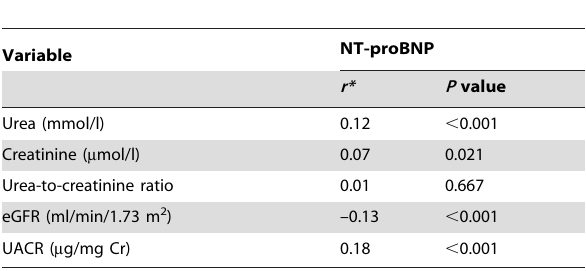
Abbreviations as in Table 1. *r, Spearman correlation coefficient.